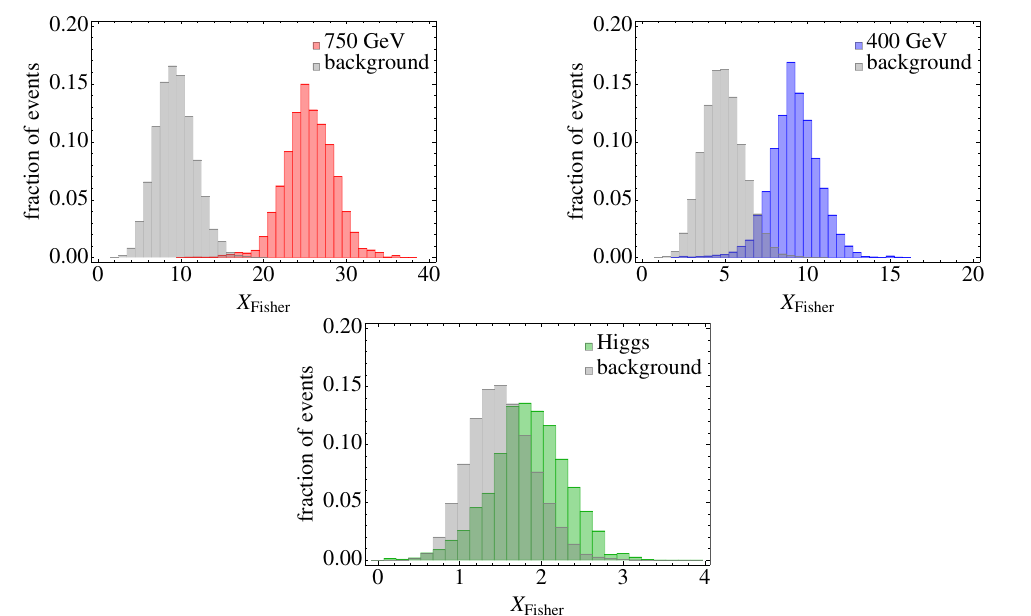
Figure 13. Fisher discriminant for signal and